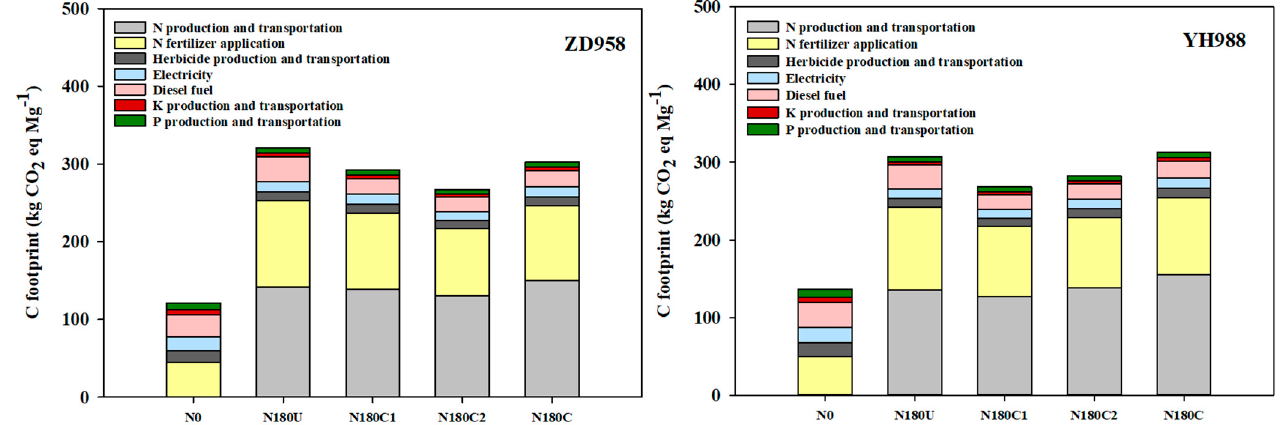
Figure 6. Average C footprint across the 2019 and 2020 growing period in the summer maize